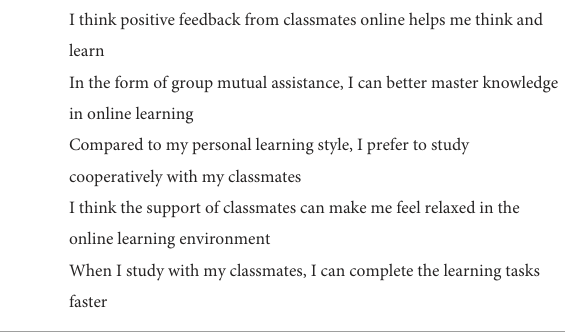
TABLE 2 Perceived peer support scale.